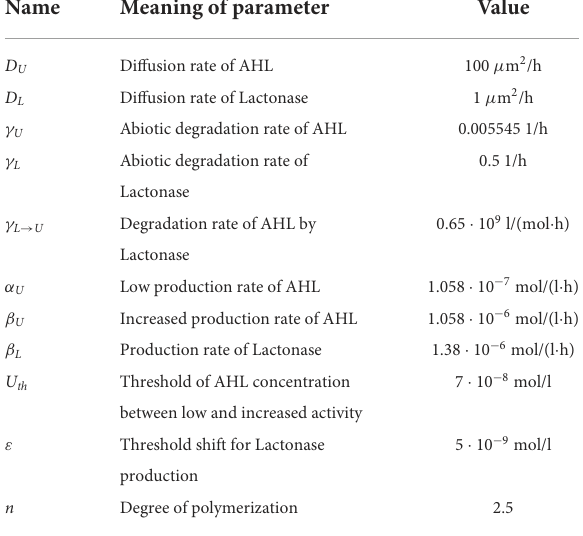
of the population due to antibiotic action. According to the above algorithm, one, two or three bacterial colonies with a circular shape can start to grow at an initial time. The initial radius R 0 of each bacterial colony is set to be 1 µ m. The parameter of the rate of logistics population growth is assumed to be r = 0.4 1/h, the limiting value of linear size is I = 20 µ m. During the bacterial evolution process, a new bacterial colony appears with a small probability specified as 0.1 per time step of the simulation, chosen to be 0.5 h . Concretely, for the first simulation, we had two bacterial colonies at the start moment and the total amount V , equaled to